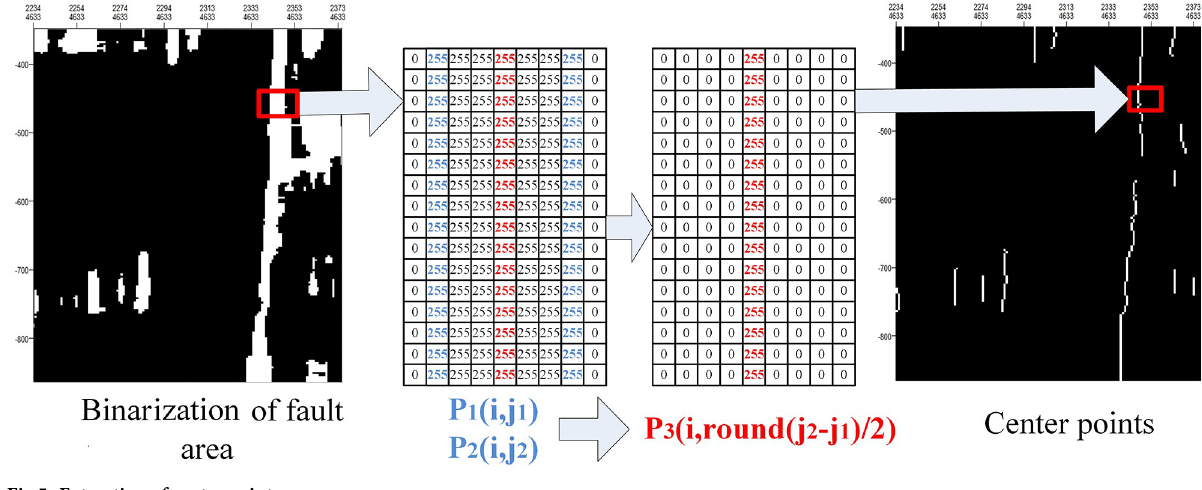
Fig 5. Extraction of center